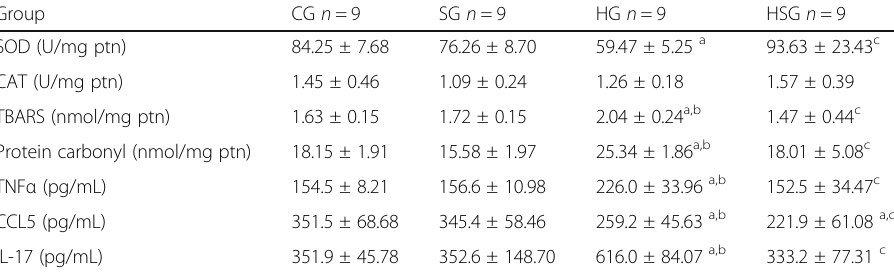
Table 2 Biochemical analysis of damage and oxidative stress and inflammatory cytokines in lung tissue homogenates